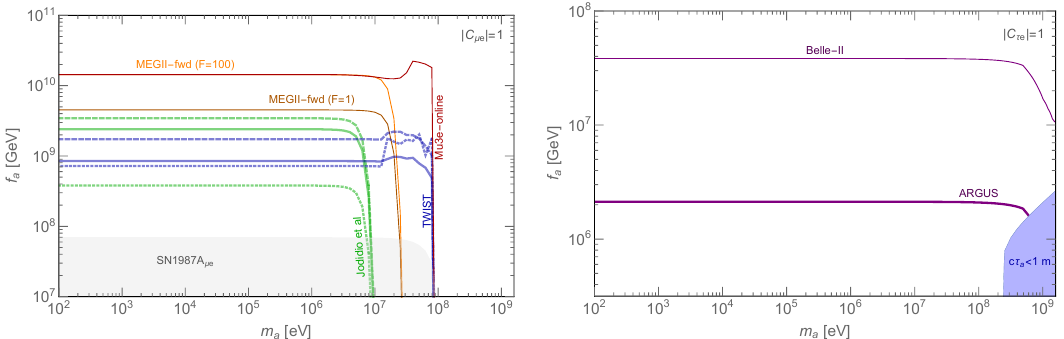
Figure 2 . Summary of the bounds and future projections for LFV ALPs. The color coding is the same as in figure 1. Left: We set C = 1 , while all the other couplings in eq. (2.1) are set µe to zero. For comparison we also show the bound on µ → ea from SN1987A derived in section 6.1 even though it is subdominant relative to the existing bounds from ground based experiments. Right: The only nonzero coupling is C τµ = 1 . The plot for C τe = 1 is similar, and is not displayed for